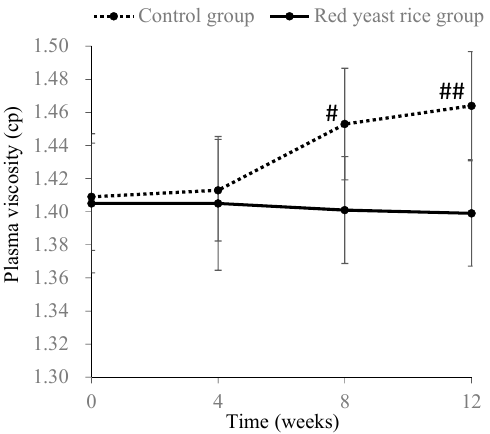
Figure 16. Time course changes in plasma viscosity in a control group and a red yeast rice-treated group in hypercholesterolemic model rabbits. Each bar indicates the mean ± standard deviation. Significant differences between control group and red yeast group were tested by Student's t-test (#: p < 0.05, ##: p < 0.01). Plasma viscosity was measured using a plate and cone viscometer according to the reference method [50].